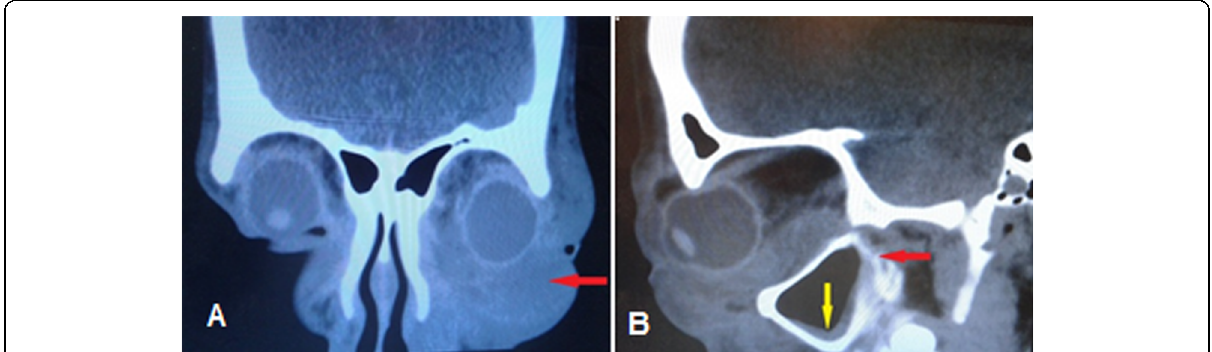
Fig. 2 A 19 year-old diabetic patient with inferior orbital cellulitis secondary to dental abscess, a Orbital CT scan coronal view revealed inferior orbital abscess (red arrow), b axial view revealed mild mucosal thickening of maxillary sinus (yellow arrow) and retro-maxillary opacity (red